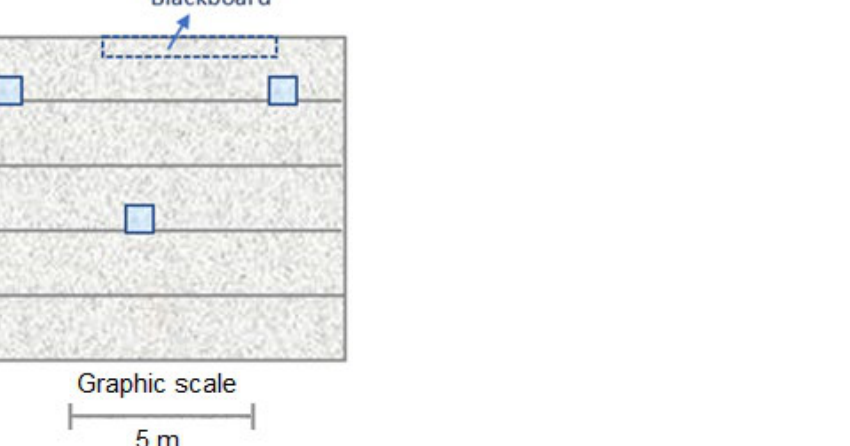
Figure 9. Location plan of the distribution of the heliostatic illuminators in the scale model of the